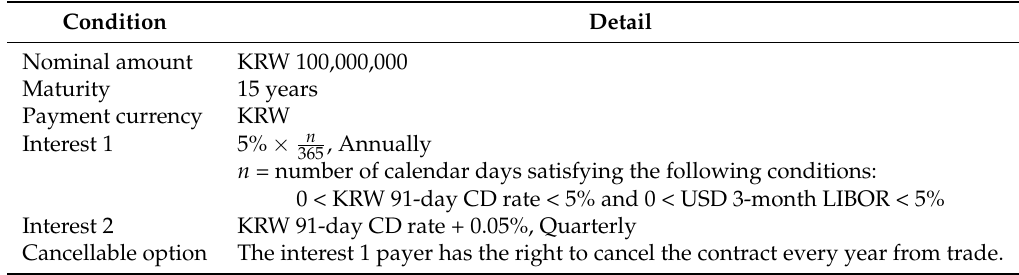
Table 1. An example of KRW dual range accrual